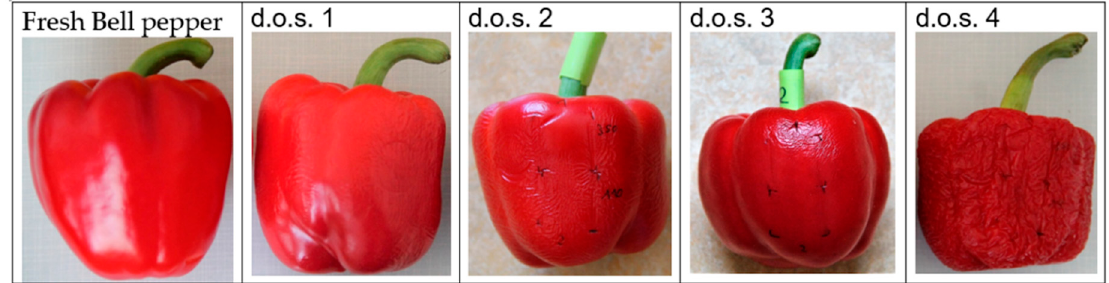
Figure 2. Shrivel development during shelf-life-designated as d.o.s.-degree of shriveling.